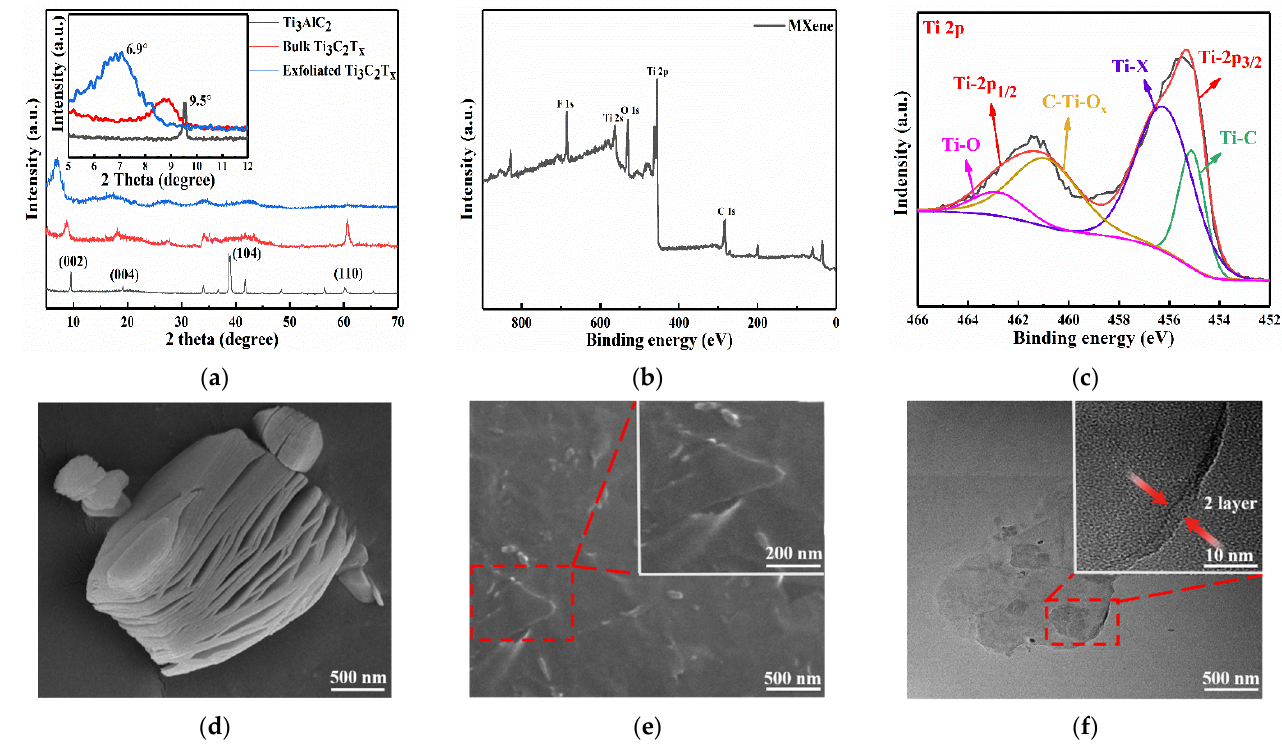
Figure 2. ( a ) XRD patterns of Ti 3 AlC 2 , bulk Ti 3 C 2 T x MXene, and exfoliated Ti 3 C 2 T x MXene. The inset shows magnified spectrum 5° to 12°; ( b ) XPS spectrum of full scan of exfoliated Ti 3 C 2 T x MXene; ( c ) high-resolution Ti 2p XPS spectra of exfoliated Ti 3 C 2 T x MXene.; ( d ) SEM image of bulk Ti 3 C 2 T x MXene; ( e ) SEM images with different degrees of magnifications of exfoliated Ti 3 C 2 T x MXene; ( f ) HRTEM images of the exfoliated Ti 3 C 2 T x with different magnifications.